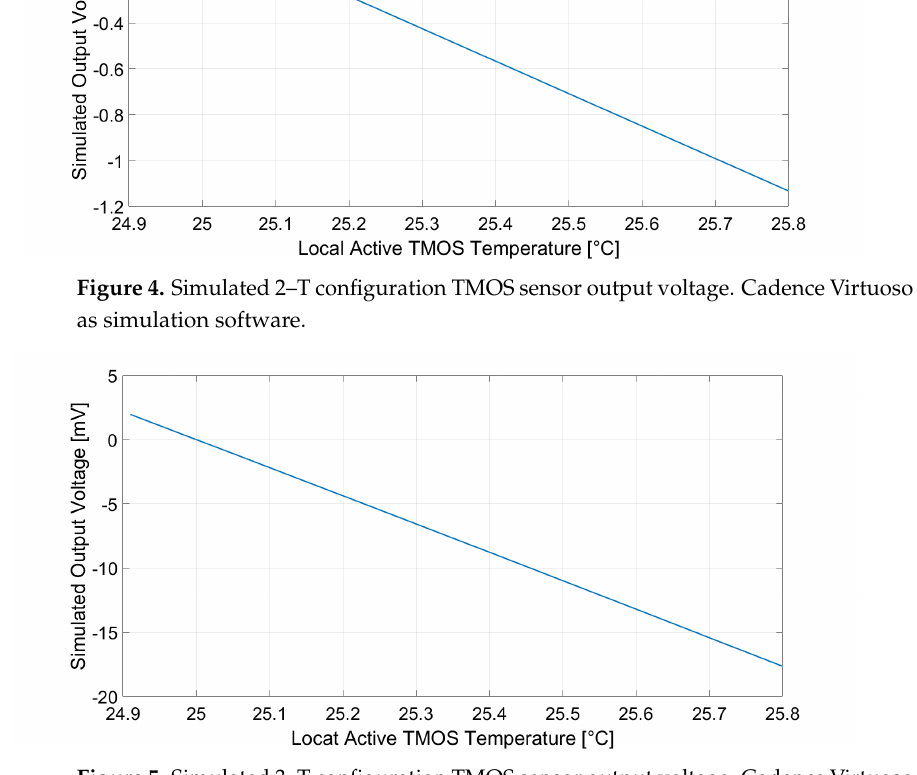
Figure 5. Simulated 3–T configuration TMOS sensor output voltage. Cadence Virtuoso was employed as simulation